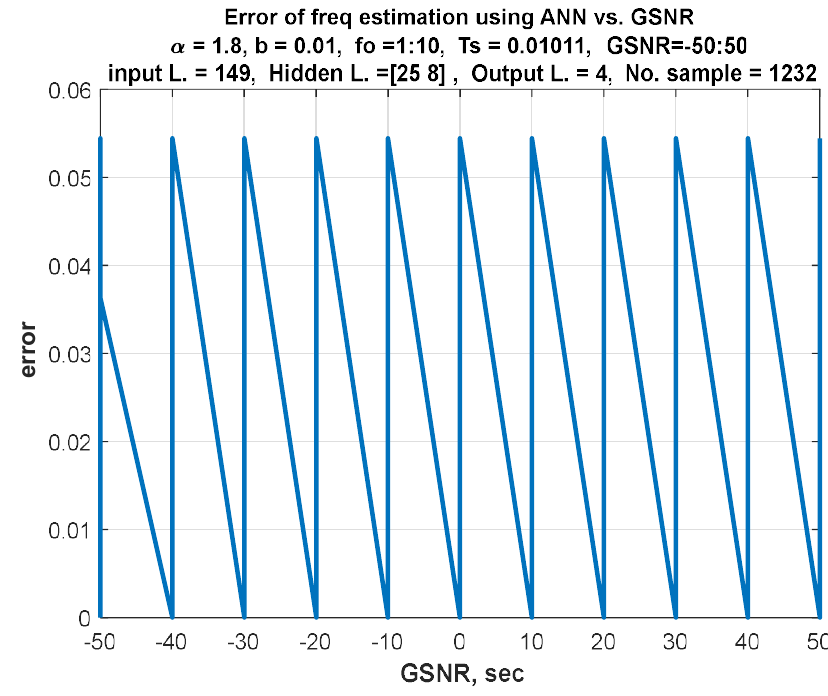
Figure 7. GSNR vs. RMSE of FE for noisy LFM by DNN.